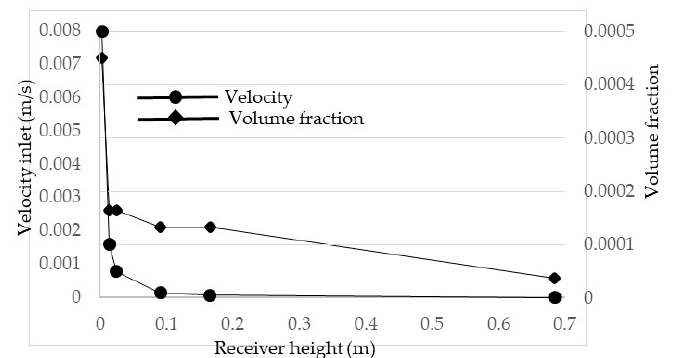
Figure 11. Relevant velocities for volume fractions for a constant peak temperature.